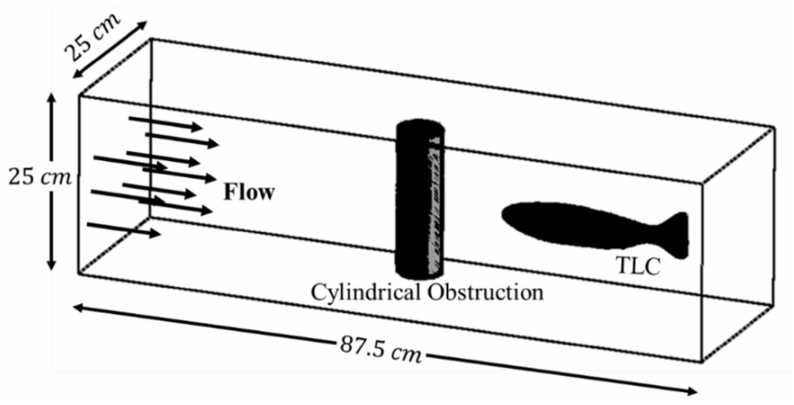
Figure 1. Computational schematic of the TLC downstream of a cylindrical